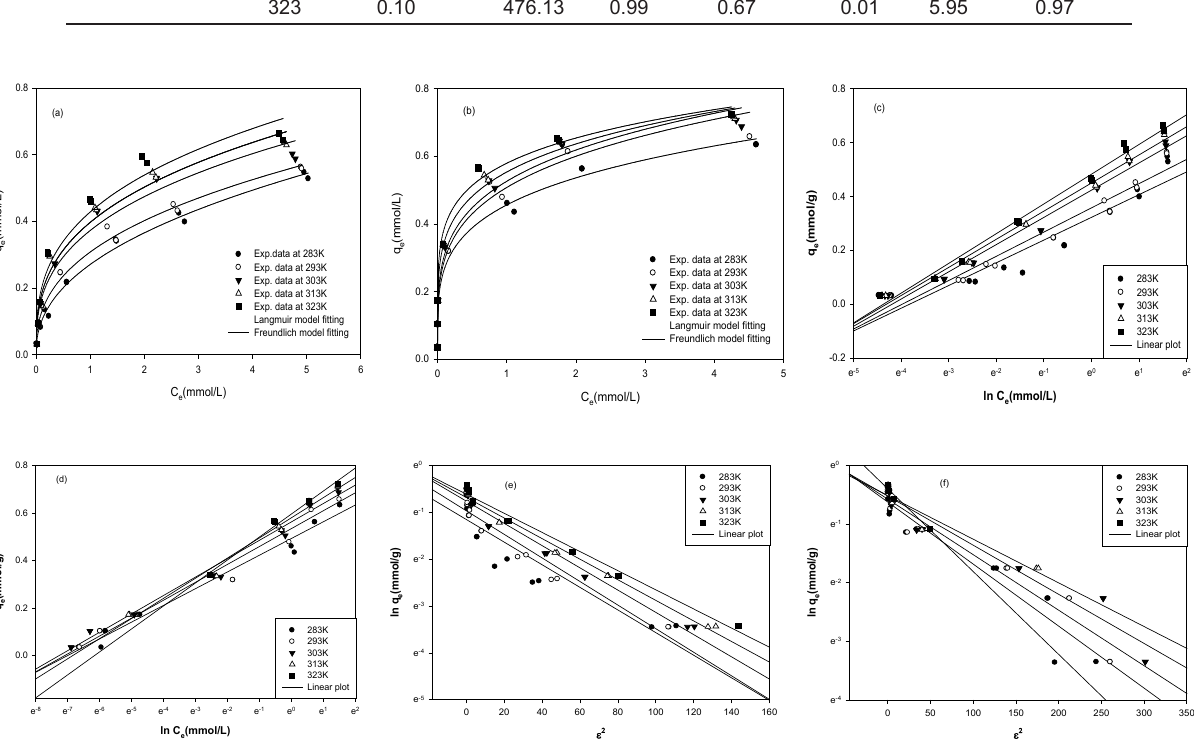
Fig. 5. Adsorption isotherm of Se(IV) by Fe-Mn LDHs and Fe-Mn DOs. a, c, d - Fe-Mn LDHs; b, d, f - Fe-Mn DOs; a, b - Langmuir and Freundlich; c, d - Temkin Isotherm and e, f - Dubinin-Radushkevich isotherm